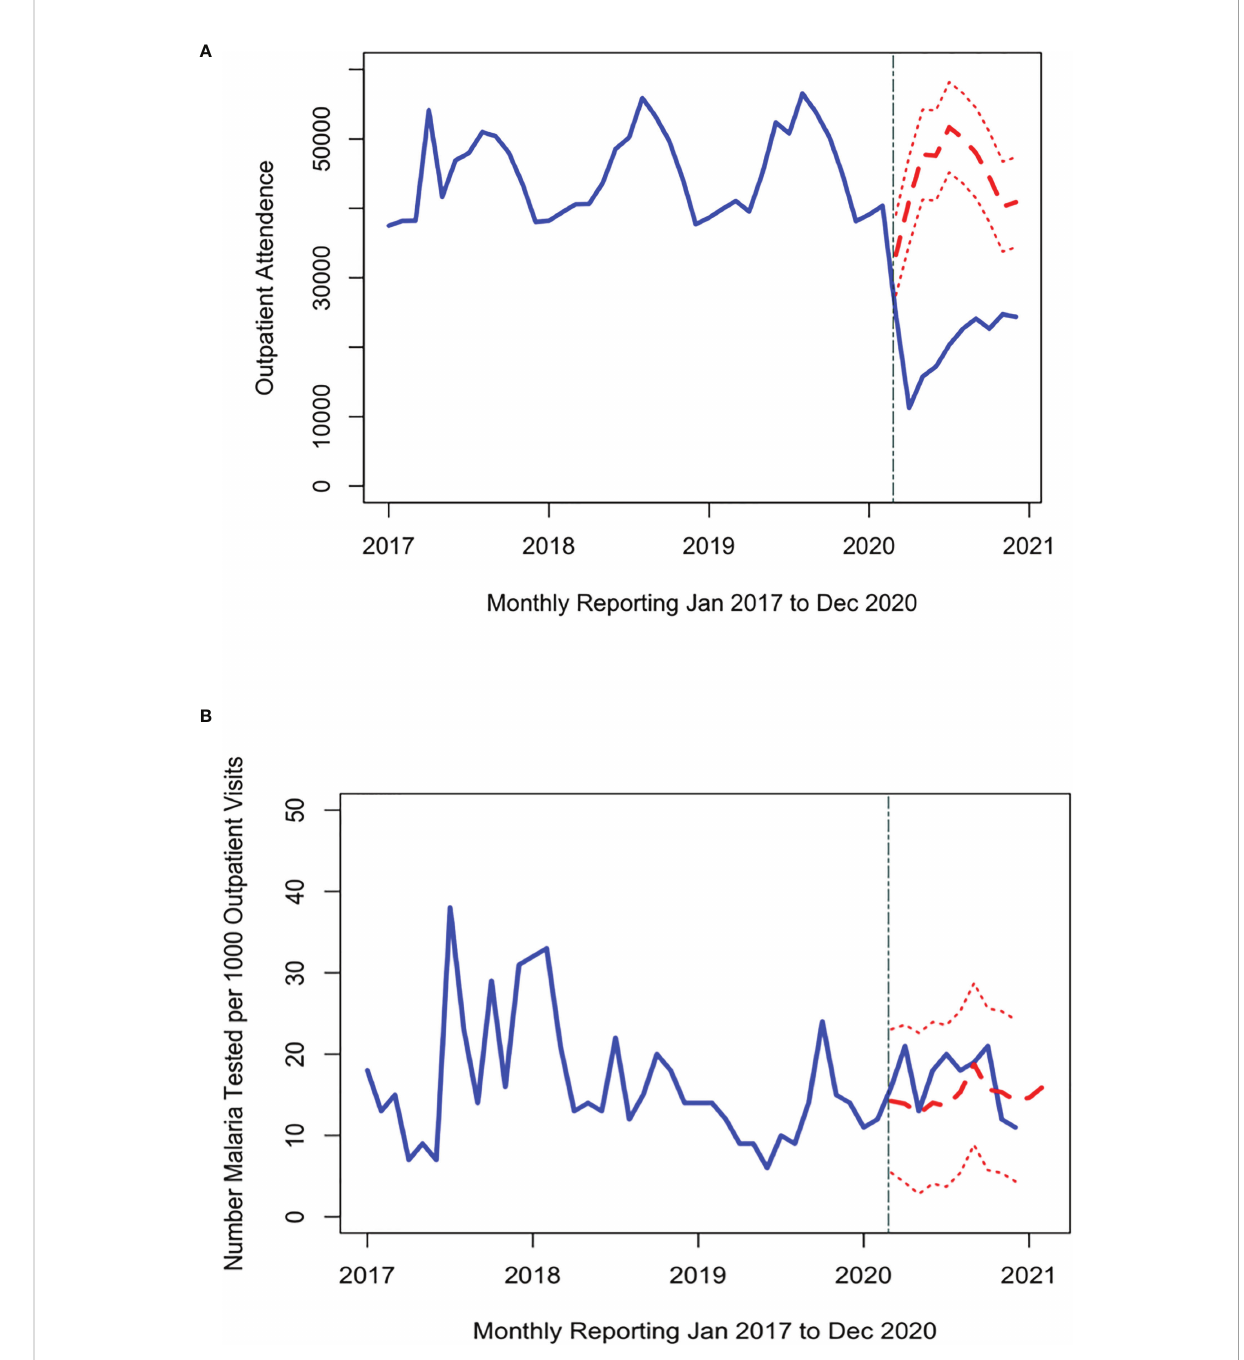
FIGURE 3 Time series of the number of people attending the outpatient department (A) and malaria tests conducted per 1000 outpatient visits (B) each month (blue line) from 2017 through 2020. The red dashed line shows the expected trend of number of malaria tests had the pandemic had no impact on malaria testing (red line with 95% credible interval). The fi rst malaria case reported in Cabo Verde is indicated by the grey dashed